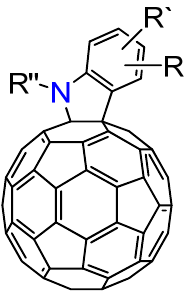
Figure 4. Molecular structure of indolino[2',3':1,2]-1,2-dihydro[60]fullerene derivatives 8 .